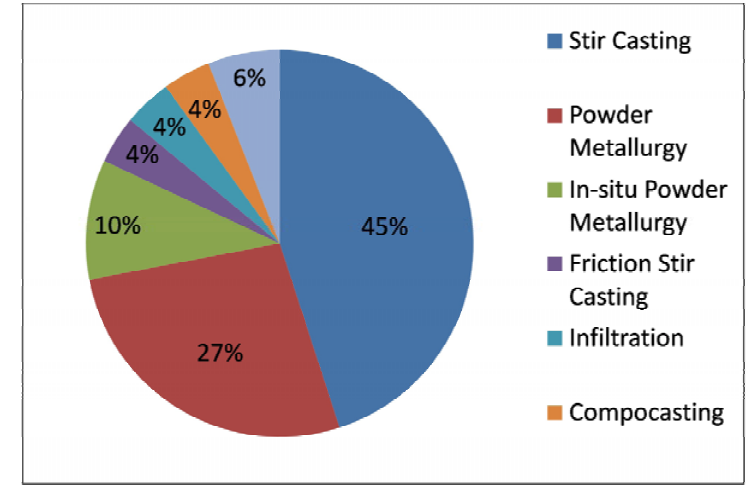
Fig. 1. Contribution (%) of different fabrication techniques for Al and Mg based MMHCs reviewed in this